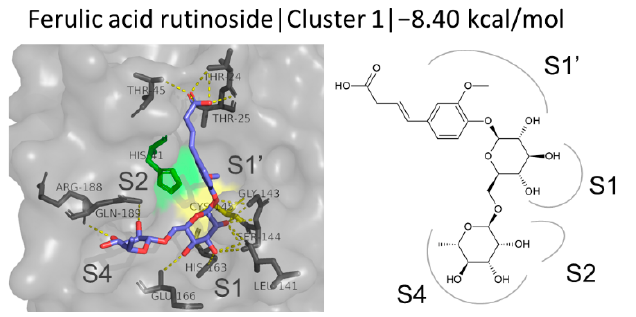
Figure 10. Structure and binding mode of FA rutinoside at the active site of M pro .